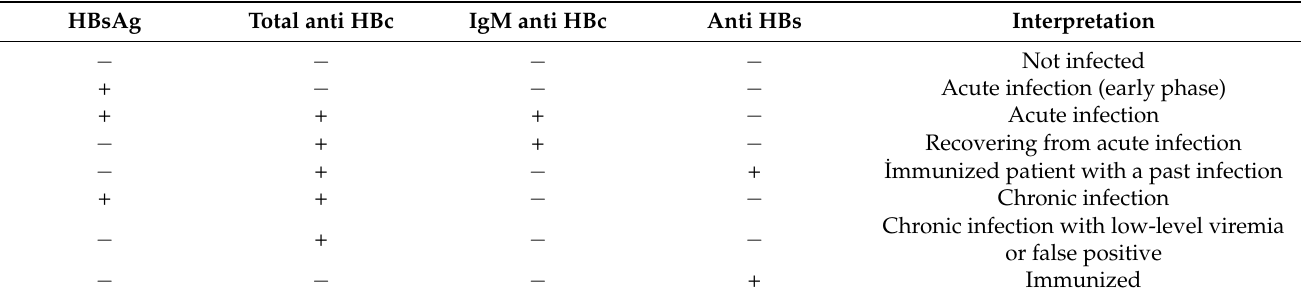
Table 1. Interpretations of serologic markers of hepatitis B